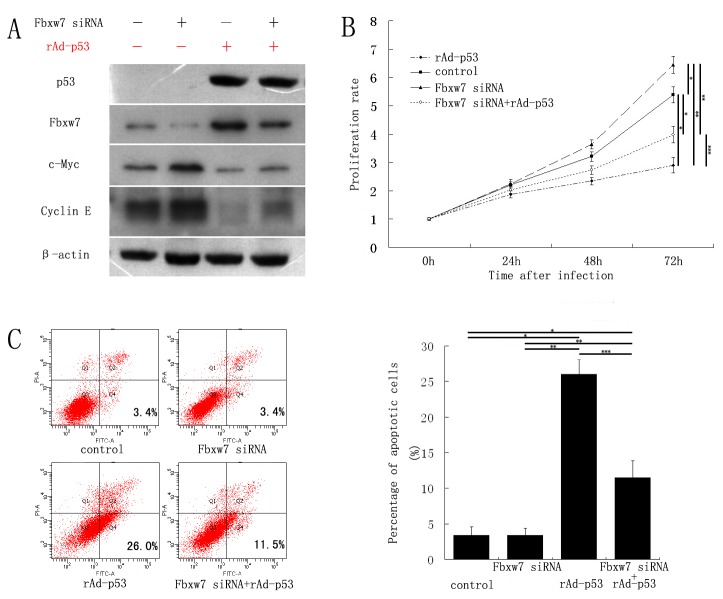
rAd-p53 induced apoptosis was reverted by Fbxw7-specific siRNA.A) Fbxw7-siRNA treatment in Hep3B successfully down-regulated Fbxw7 protein but enhanced c-Myc and Cyclin expression as shown by immunostaining. Over-expression of rAd-p53 in the same cell line could enhance the levels of Fbxw7 and decrease c-Myc and Cyclin E expression. Fbxw7 knockdown in p53 over-expressing cells rescued partially the phenotype showing lower Fbxw7 levels with higher c-Myc and Cyclin E expression. β-actin served as loading control. B) The proliferation rate of rAd-p53 infected Hep3B cells was increased in the presence of Fbxw7-specific siRNA (MTT assay). C) The percentage of apoptotic Hep3B cells infected with rAd-p53 was decreased by Fbxw7-specific siRNA. Values are mean±standard error, n=3. * P<0.05 vs control; ** P<0.05 vs Fbxw7 siRNA; *** P<0.05 vs rAd-p53.